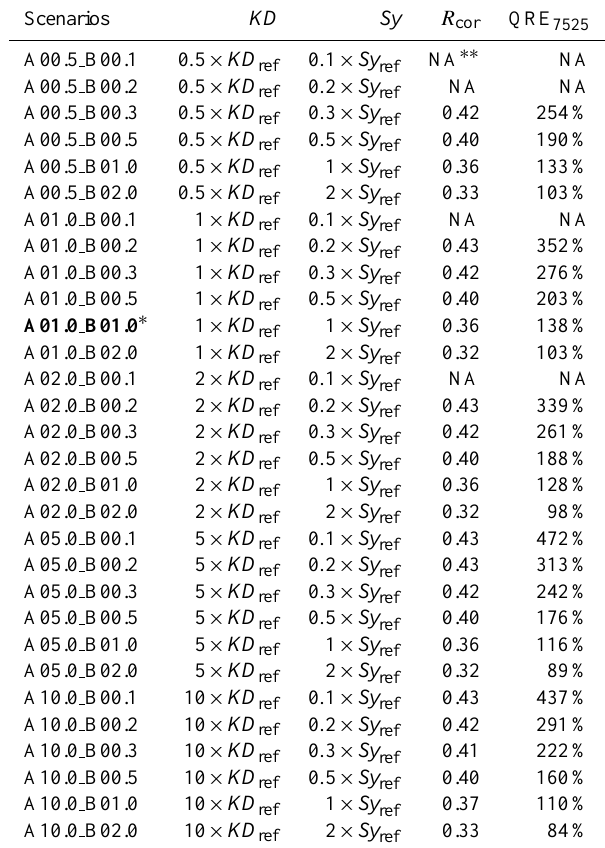
Table 4. List of the sensitivity analysis scenarios including their performance indicators presented in basin-scale average